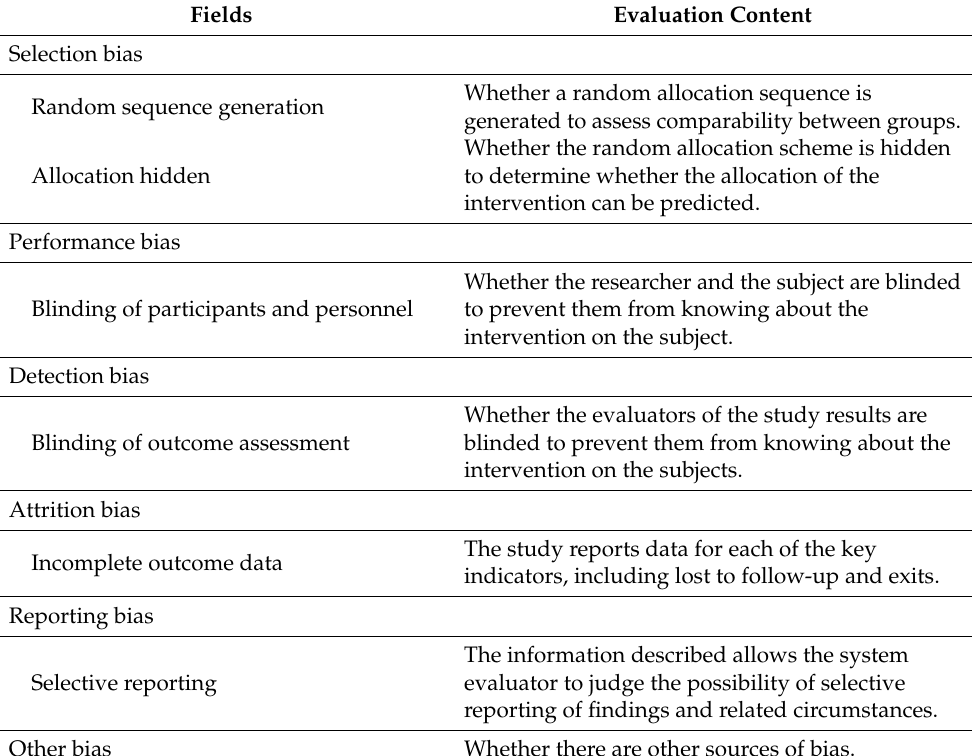
Table 2. Evaluation content based on the Cochrane risk assessment